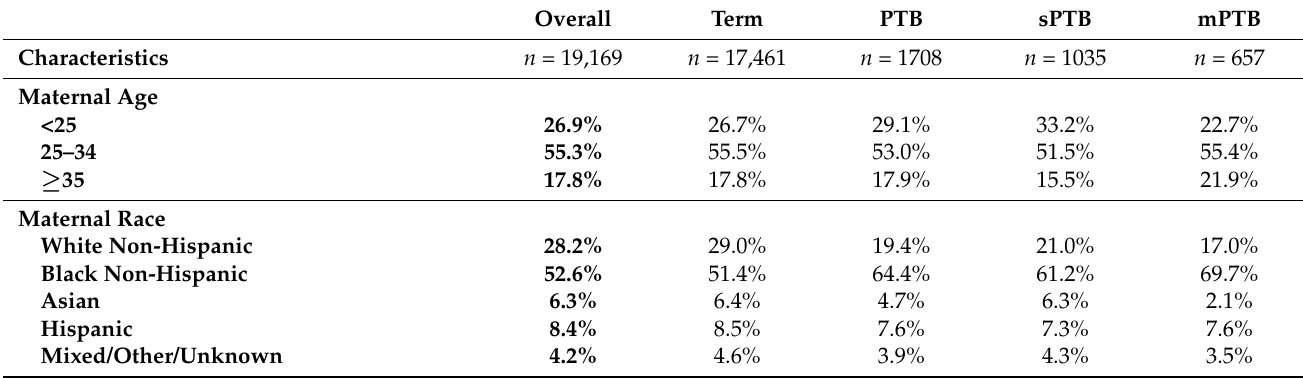
Table 1. Maternal demographics, environmental characteristics and birth outcomes of the study cohort, stratified by term birth, preterm birth (PTB), spontaneous PTB (sPTB) and medically indicated PTB